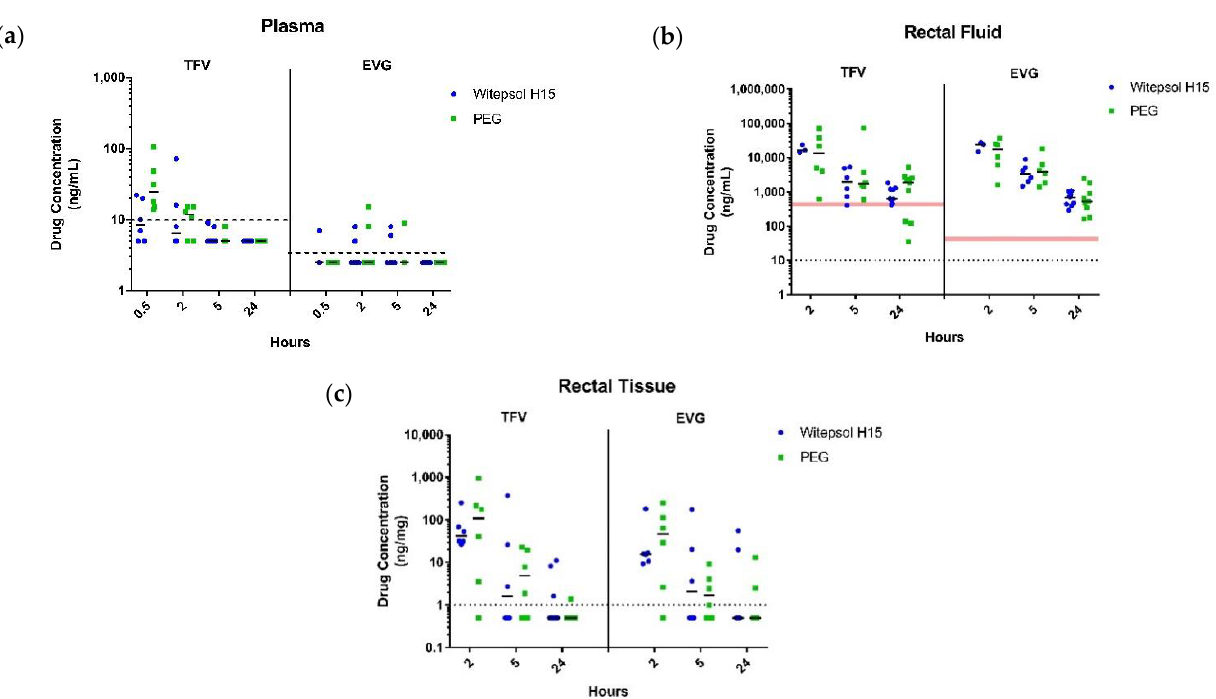
Figure 2. In vivo pharmacokinetic assessment following rectal administration of TFV/EVG (40 mg/40 mg) suppositories formulated in witepsol H15 or PEG base in macaques. TFV and EVG levels in plasma ( a ), rectal fluids ( b ), and rectal biopsies ( c ). Dotted line represents the lower limit of quantitation (LLOQ). Red shaded line represents in vitro IC 50.